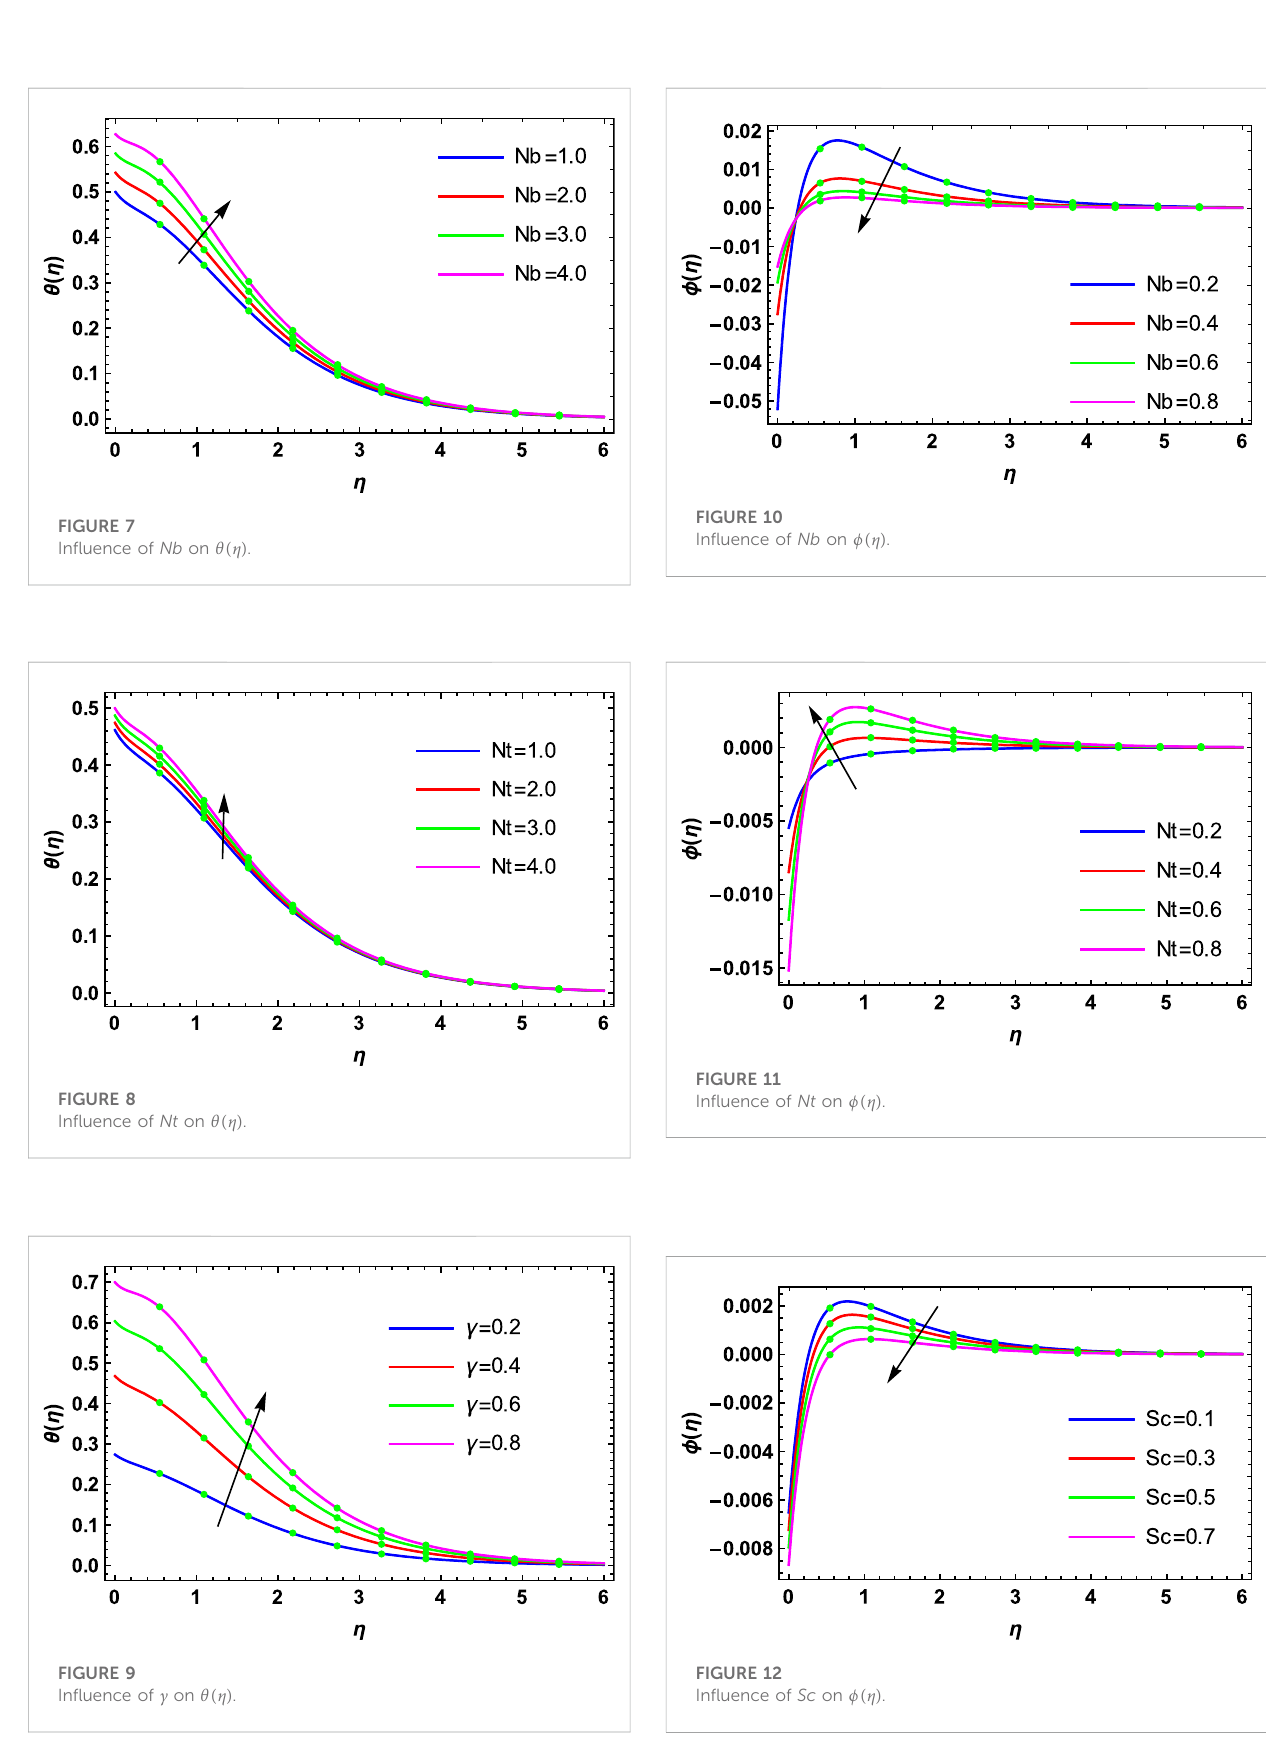
FIGURE 9 In fl uence of γ on θ ( η ) .